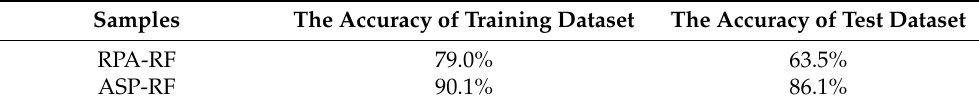
Table 3. Accuracy data for the training and test datasets of the RPA-RF and ASP-RF models.